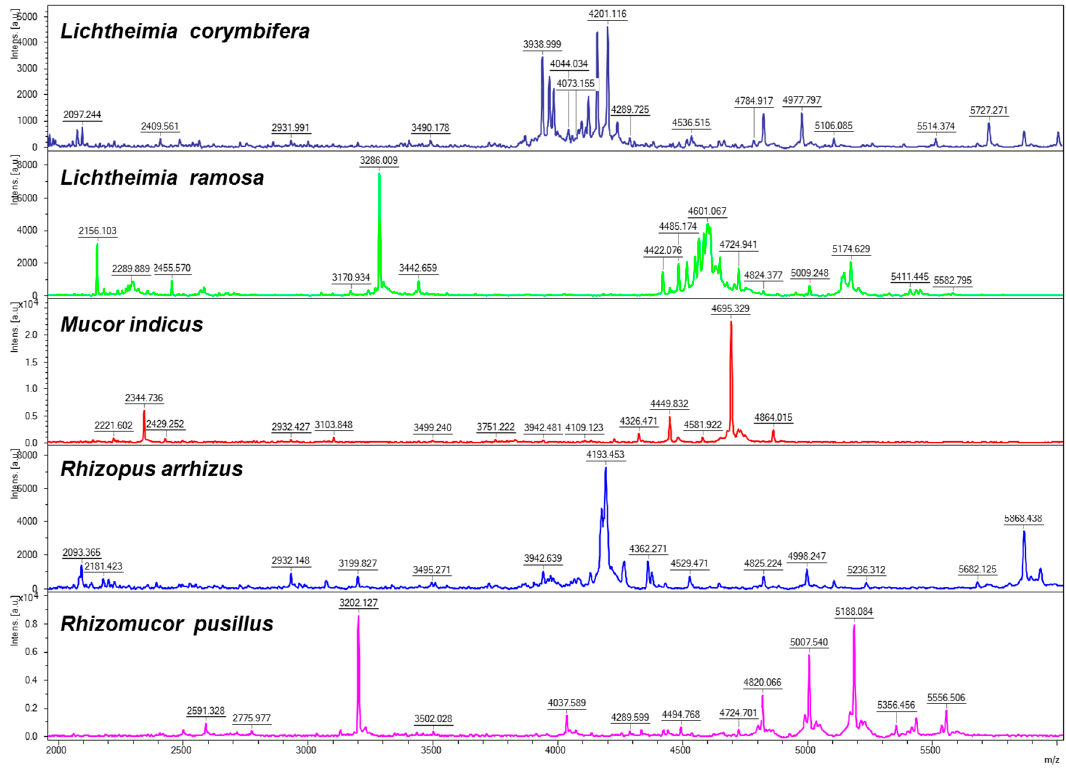
Figure 1. Typical spectra patterns obtained for five different species of Mucorales.